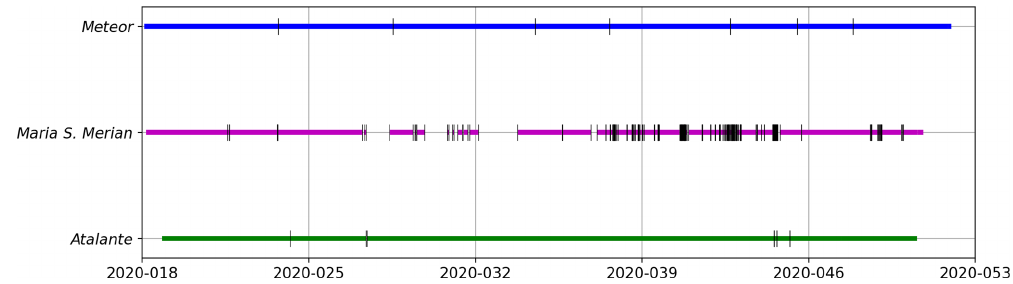
Figure 3. Availability of ship-borne GNSS measurements (from RINEX files) during the EUREC 4 A campaign. Vertical black marks denote interruptions in